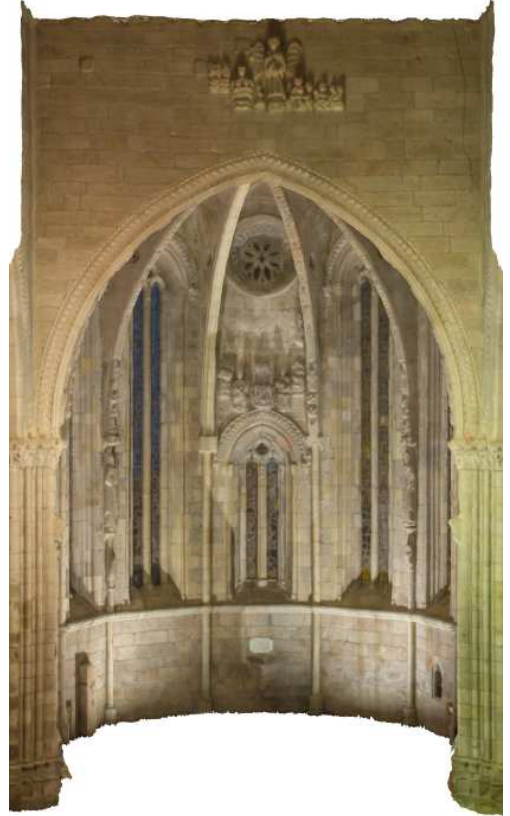
Figure 8. Front apse